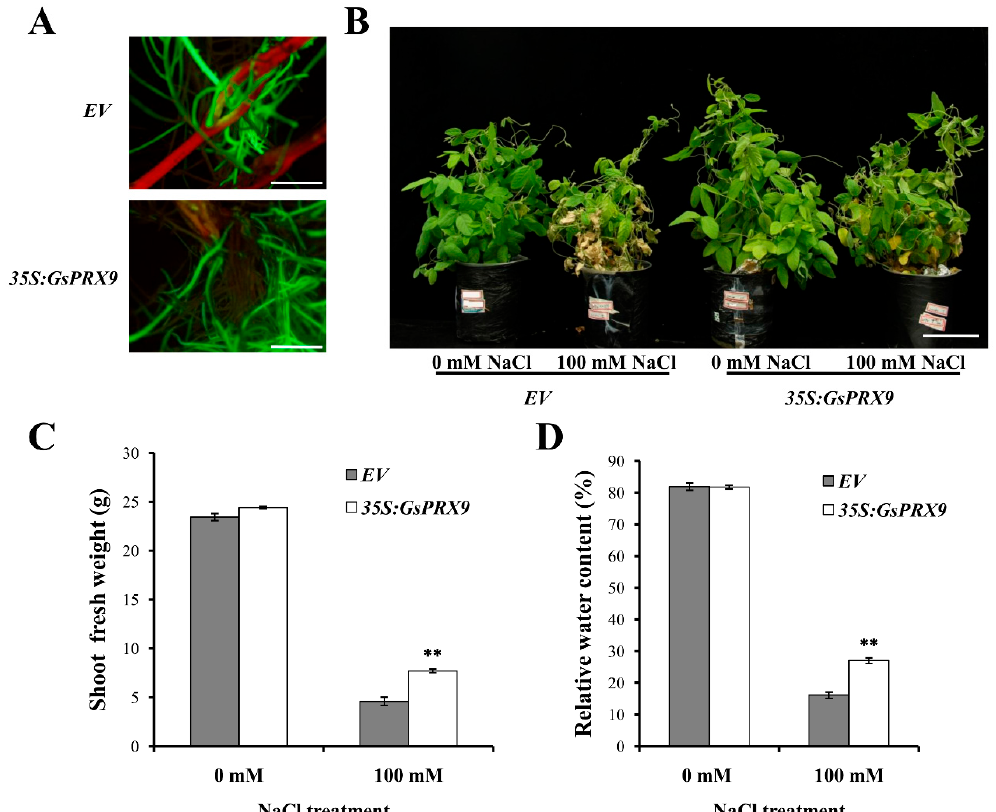
Figure 4. Salt tolerance analyses of transgenic soybean composite plants. ( A ) Identification of positive transgenic soybeans by green fluorescence using a stereoscopic fluorescence microscope. Bar = 1 cm. ( B – D ) Phenotype, shoot fresh weight, and leaf relative water content of transgenic soybean composite plants under 0 mM or 100 mM NaCl for seven days, respectively. Bar = 5 cm. EV represents plants with the empty vector pBinGFP4 and 35S:GsPRX9 represents plants with the recombinant vector pBinGFP4– GsPRX9 ( GsPRX9 was expressed in fusion with GFP, driven by a CaMV 35S promoter). Data represent the mean ± standard deviation of three biological replications and each repeat contained 10 independent transgenic plants ( n = 3 × 10 = 30). ** represents significant di ff erence between EV and 35S:GsPRX9 under the same conditions at the 0.01 level by Student’s t -test.